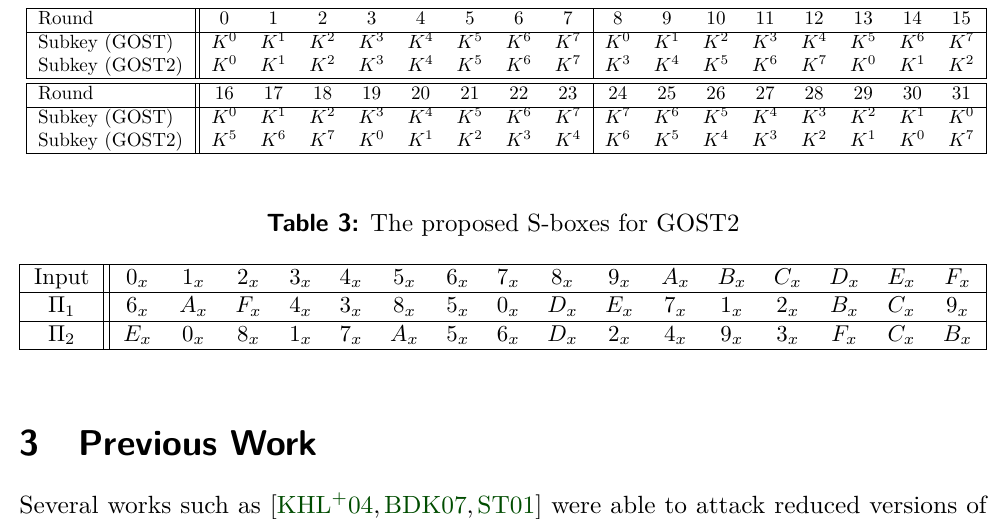
Table 2: The order of subkeys in GOST and GOST2